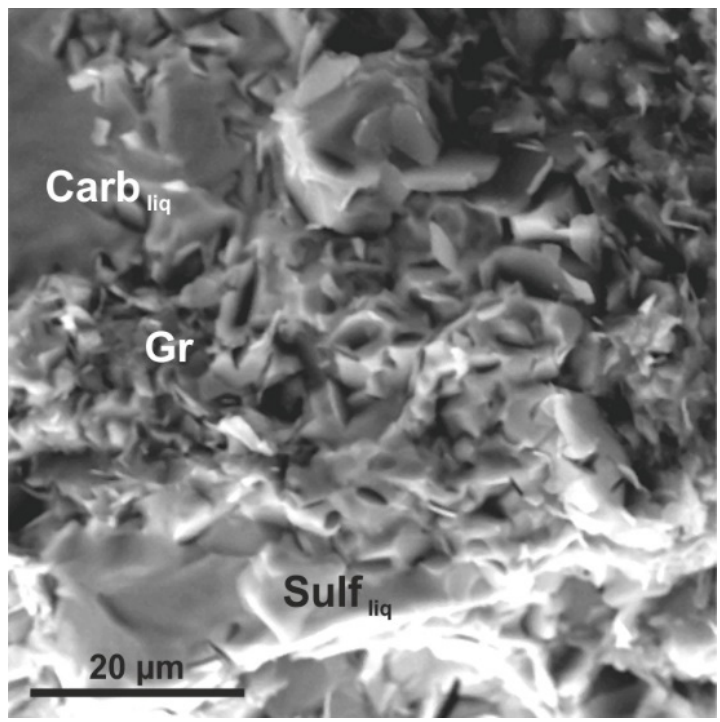
Figure 3. SEM micrograph (BSE regime) of cleavage surface of the sample from the experiment with MgO capsules, illustrating graphite formation in the presence of a single one-carbon source (run # 2003-M, 1450 °C). Initial reagents were thinly powdered and thoroughly homogenized. Three seed diamond crystals of cuboctahedral habit (~500 μm in size) were placed in the reaction volume of the capsules to obtain information on the possibility of diamond growth at P,T, ƒO , x-parameters of the experiments. 2